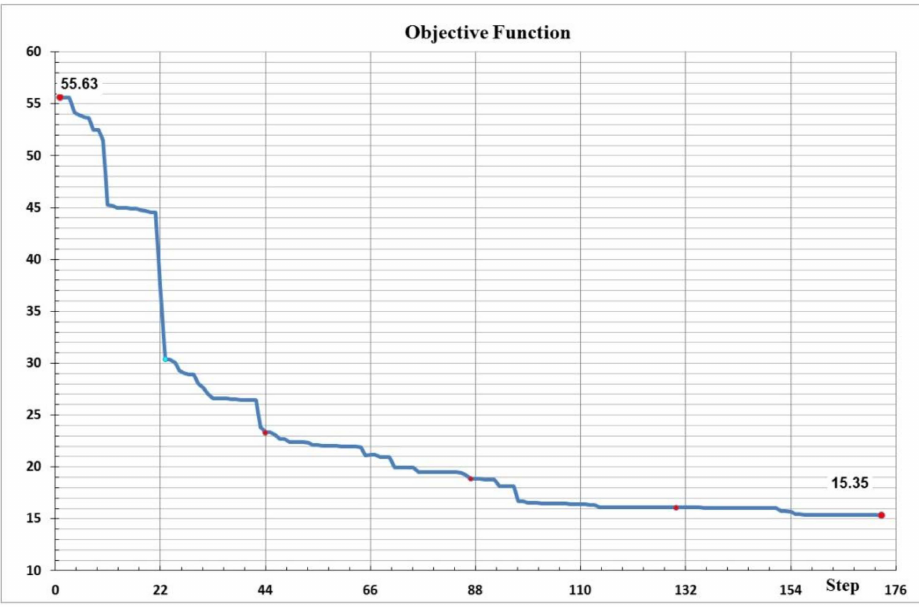
Figure 4. Dynamics of step-by-step changes of the objective